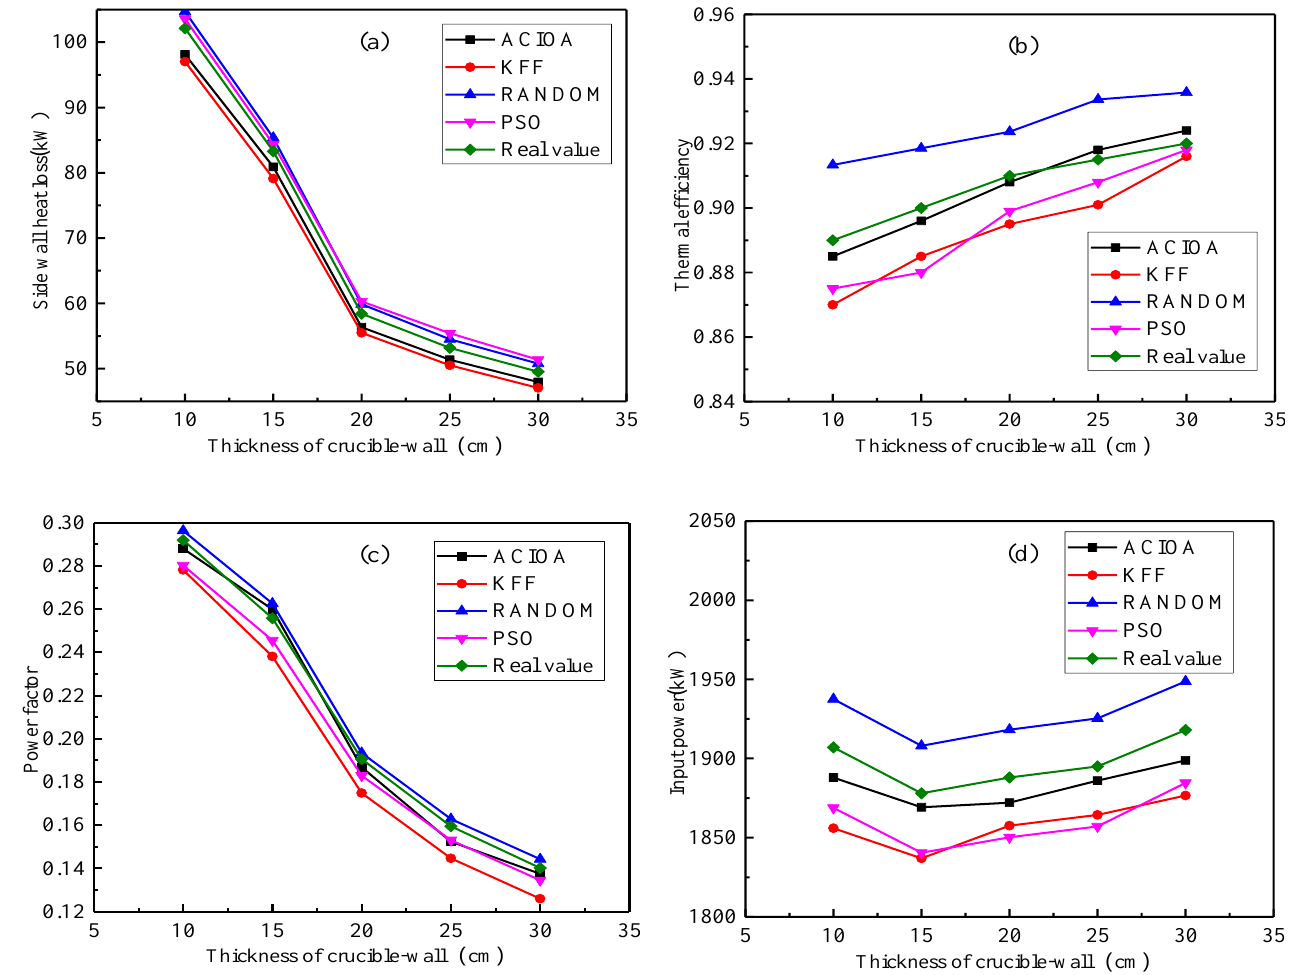
Figure 6. Effect of thickness of crucible wall on circuit performance parameters. ( a ) side-wall heat loss; ( b ) thermal efficiency; ( c ) power factor; ( d ) input power.